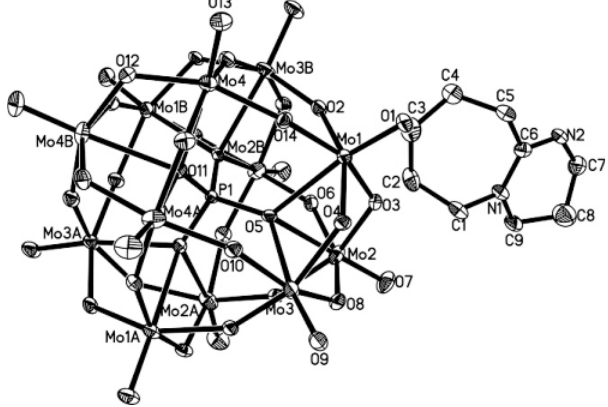
O ] 3– . 12 40 O ] 3– , the central P atom is 12 40